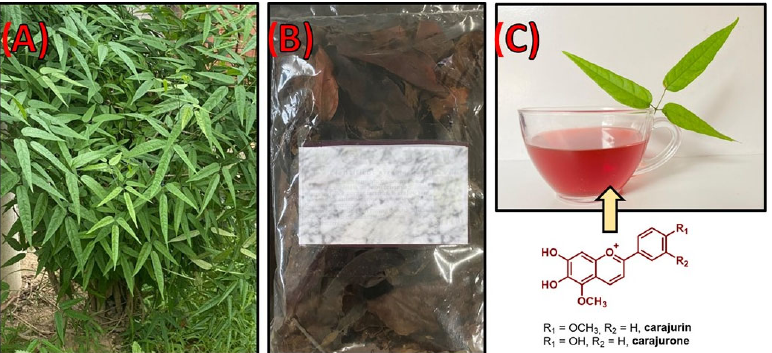
Figure 1. Fridericia chica (Bonpl.) L. G. Lohmann: specimen and presentations forms. ( A ) Arboreal specimen of adult F. chica in situ in the city of Manaus, Amazonas Brazil. ( B ) Dried leaves of F. chica as marketed in the city of Manaus, Brazil. ( C ) Tea obtained from the dried leaves of F. chica and its main compounds responsible for the characteristic color. Photos: Author.